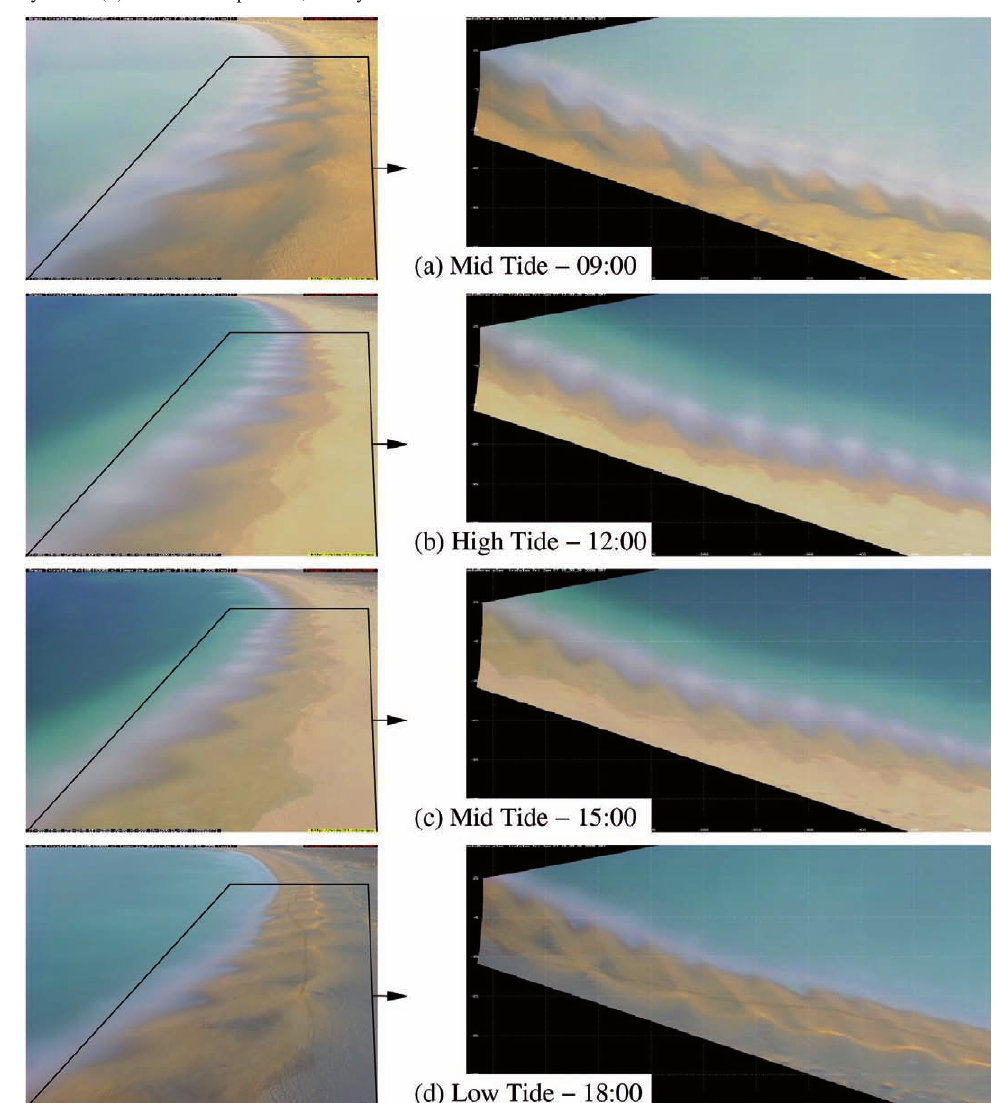
Fig . 5. – Snapshot of the cusps during a tide excursion, 7 January 2005. Left: timex images from camera 2. Right: Plan view after